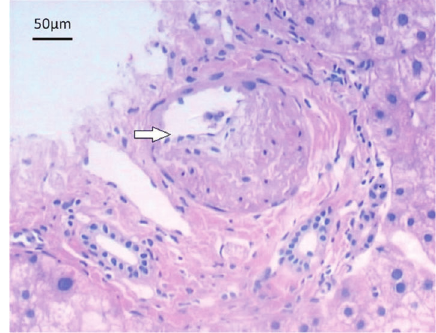
Figure 4. Microscopic image of a section of the liver taken following biopsy. The arrow shows the enhanced thickness of the hepatic portal vein wall in the portal area. Note that the venous lumen is not fully occluded. Hematoxylin-eosin staining, 100 (cid:1)